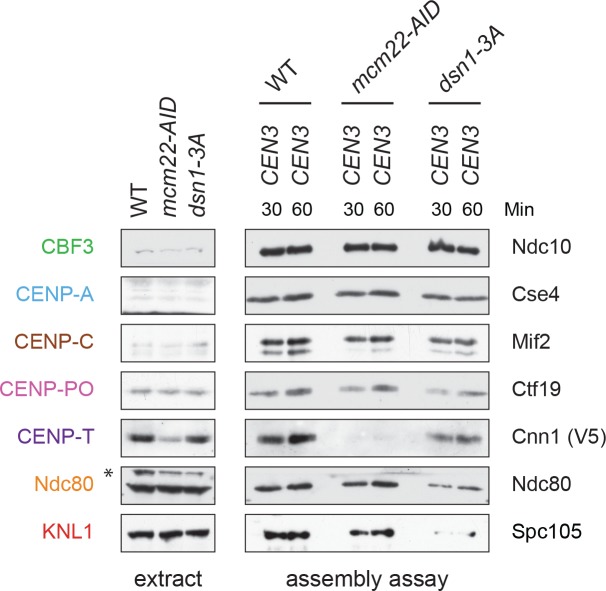
Cnn1 recruitment is blocked in Mcm22-3HA-AID strains.Whole cell extracts and assembly assays for strains DSN1-3Flag CNN1-3V5 OsTIR1 (SBY18040), DSN1-3Flag CNN1-3V5 mcm22-3HA-AID OsTIR1 (SBY18042), and dsn1-3A-3Flag CNN1-3V5 OsTIR1 (SBY18028). (C) Mcm22-3HA-AID degradation for the experiment in Figure 7C.